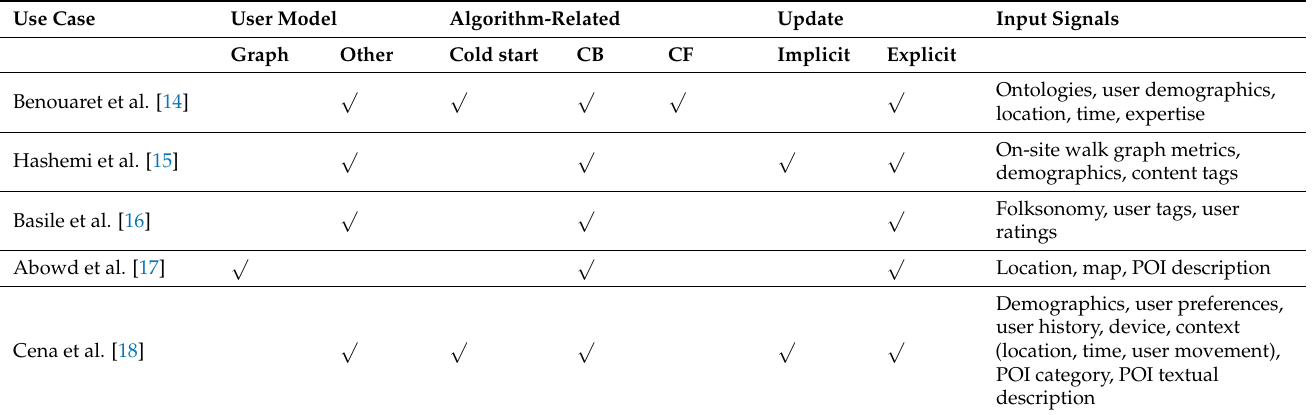
Table 1. Summary of existing recommendation approaches in CH and their corresponding character- √ istics, which are marked with a “